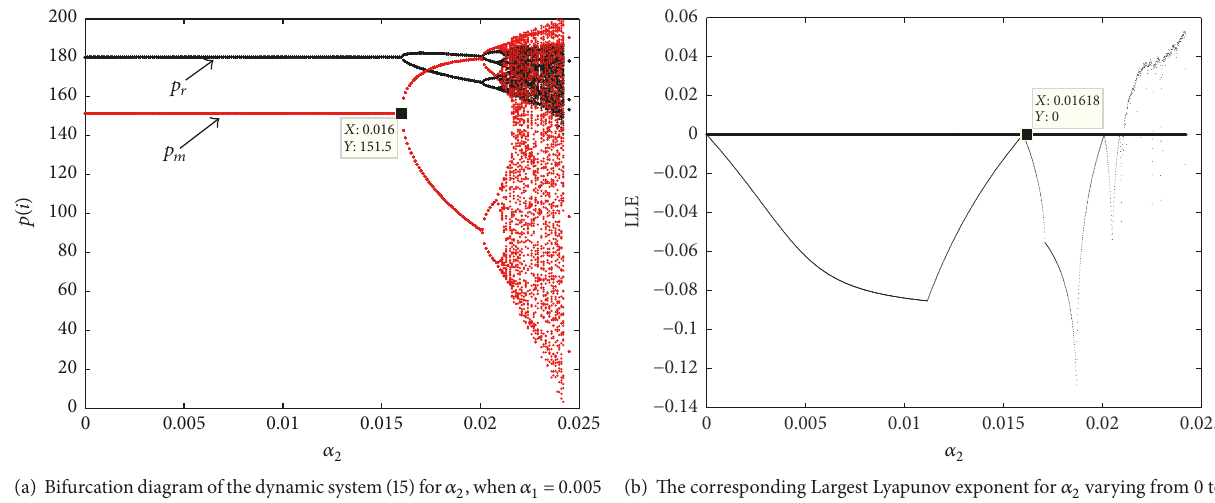
Figure 3: The bifurcation diagram and LLE with respect to 𝛼 2 .